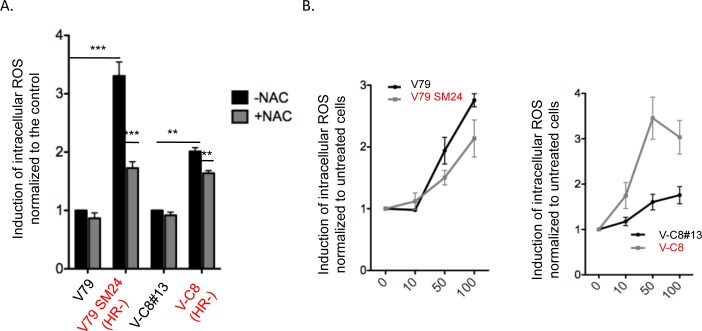
Level of intracellular ROS.A/ endogenous ROS. NAC: 2mM. The mean value +/- s.d. was calculated from at least three independent experiments. B/ After exposure to H2O2. The value +/- s.d. was calculated from at least three independent experiments.